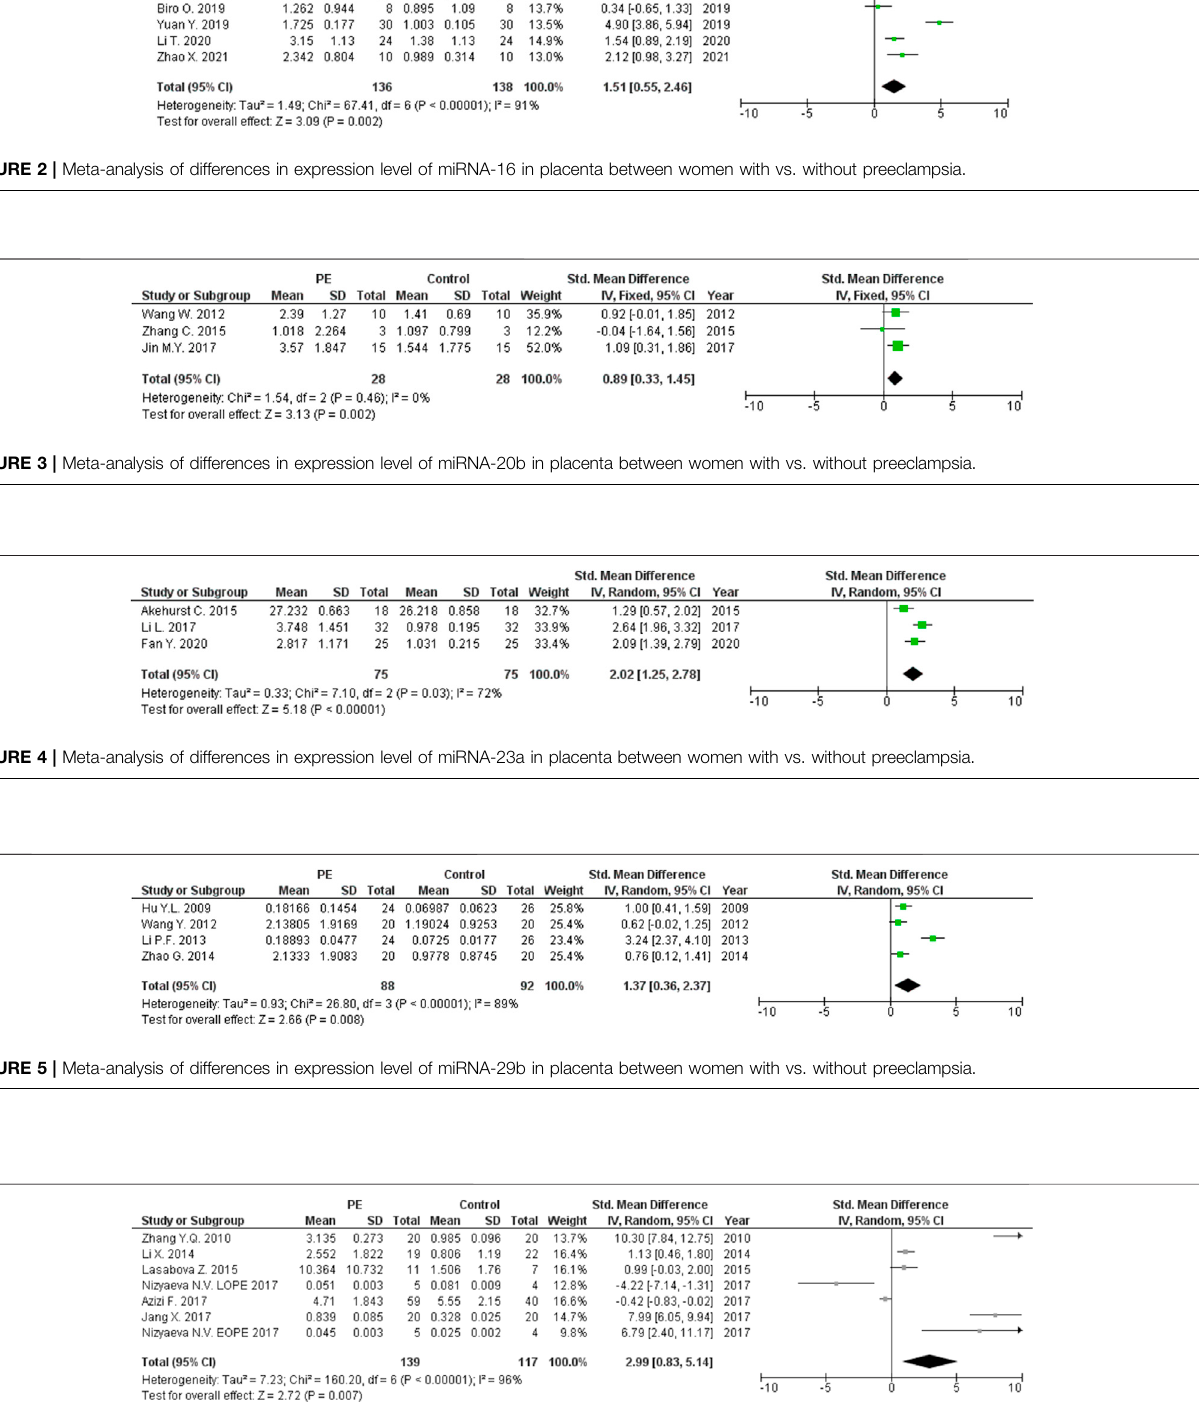
FIGURE 6 | Meta-analysis of differences in expression level of miRNA-155 in placenta between women with vs. without preeclampsia.